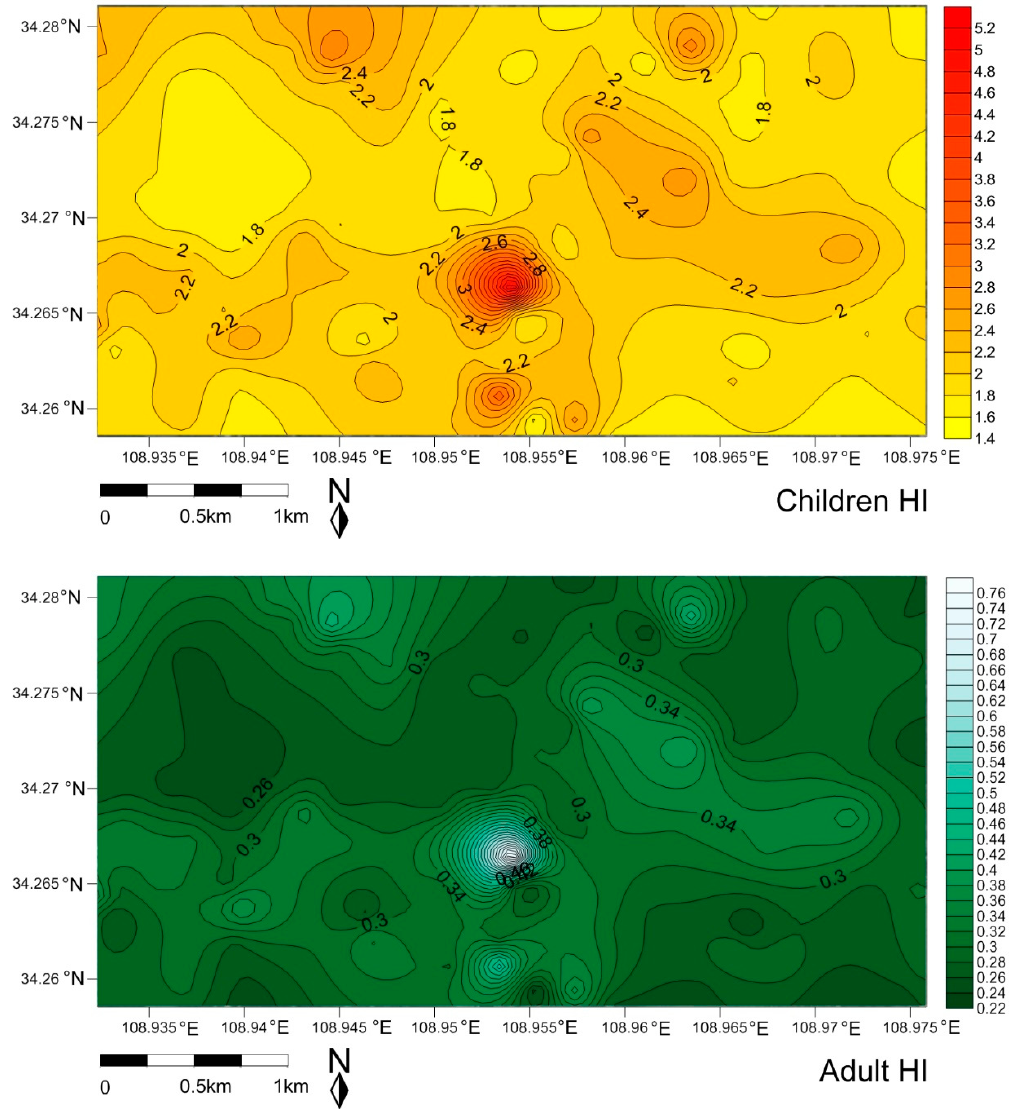
Figure 6. The spatial risk of total non-carcinogenic for children and adult exposure to the traffic-related multi-trace metals/metalloids in street dust.